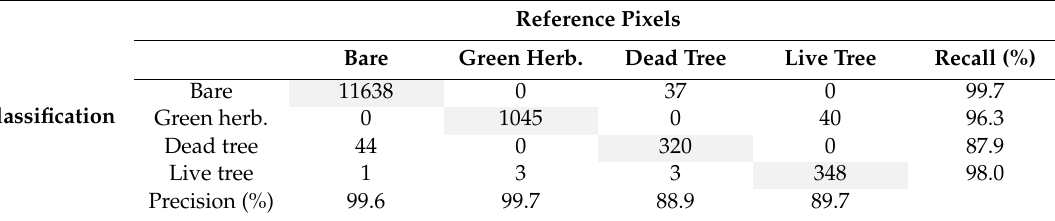
Table 4. WorldView-2 classification (1 September 2018 image) confusion matrix. Overall accuracy = 96%.